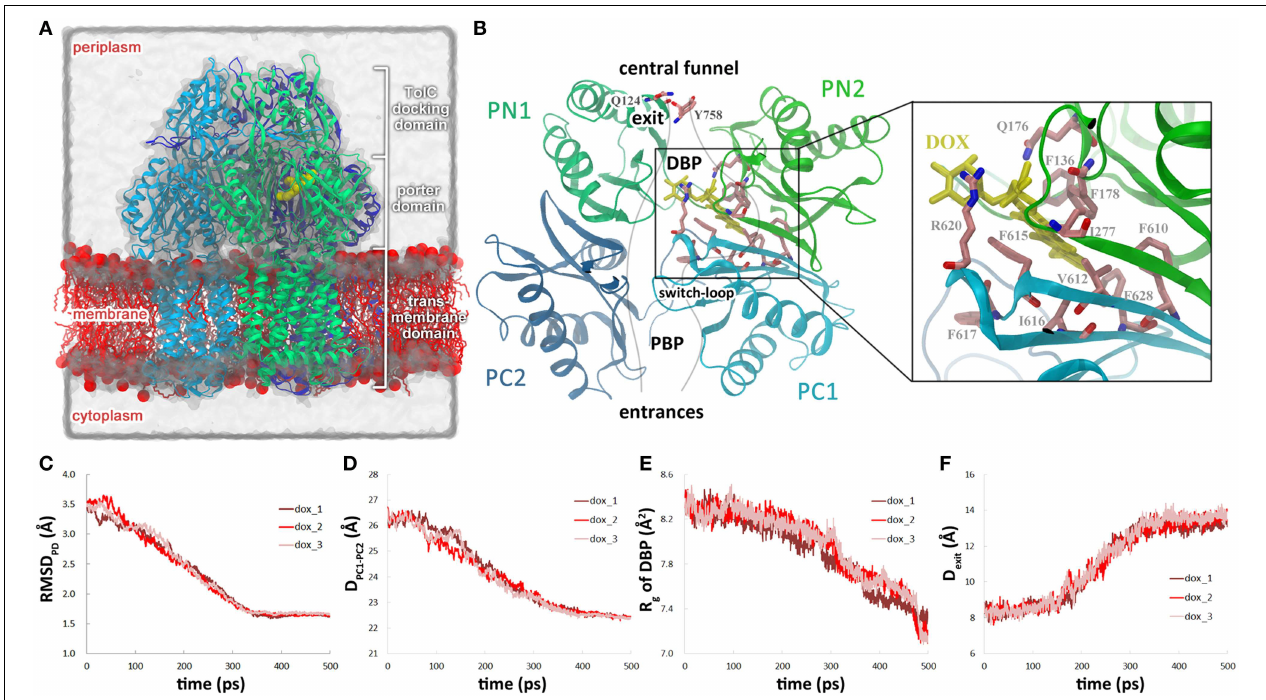
FIGURE 1 | Conformational changes of the translocation pathway in the dox system. (A) Simulation system of AcrB trimer buried in POPE bilayer and solvated with water molecules. A, B, and E monomers of AcrB in cartoon representation are colored in cyan, green and blue, respectively. Doxorubicin bound in the DBP of B monomer is shown in the VDW representation (yellow). Lipid molecules are colored in red with the charged head groups shown as balls and the hydrophobic tails as sticks. Some lipid molecules are removed for clarity. (B) A schematic view of the substrate translocation pathway in B monomer (gray lines). Subdomains PC1, PC2, PN1, and PN2 are colored in blue, cyan, dark green, and green, respectively. The residues lining the DBP is represented by the licorice mode and colored